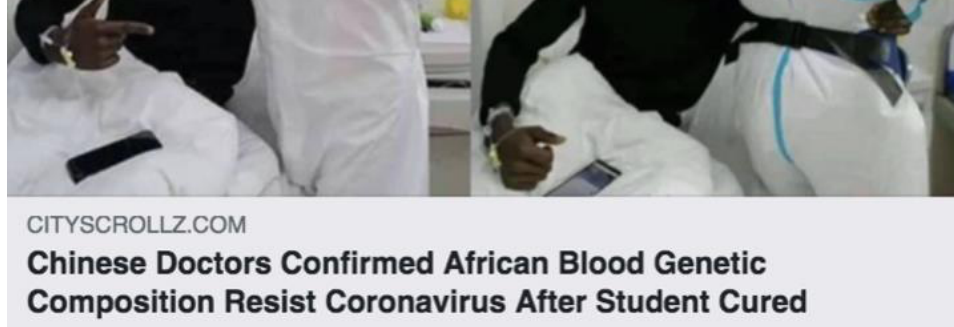
Figure D2. False 1.